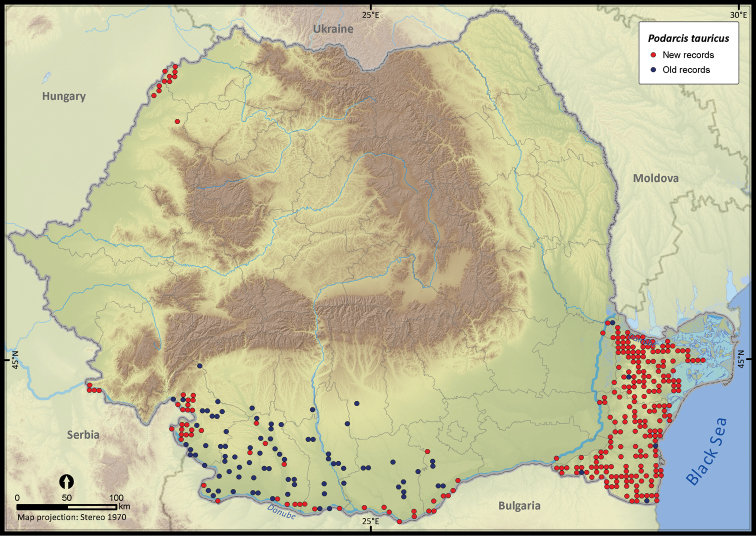
Podarcis tauricus.